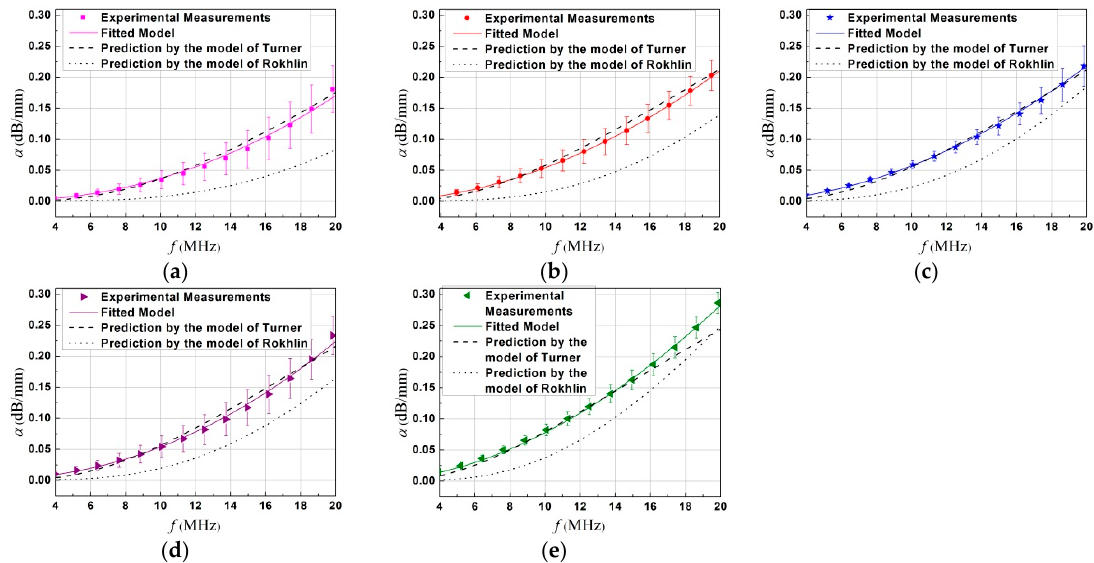
Figure 7. Comparison in attenuation coefficient versus frequency between experimental estimations and two different theoretical models: (i) the Rokhlin’s model [16] considering a single mean grain size, and (ii) the improved Turner’s model [22] incorporating a log-normal distribution of grain sizes, for a longitudinal wave in α‐ titanium alloy annealed at 800 °C holding for ( a ) 0.5 h, ( b ) 1 h, ( c ) 2 h, ( d ) 4 h, and ( e ) 8 h. The solid curves correspond to fitted results using an approximate power function in Equation (3). (Color online).